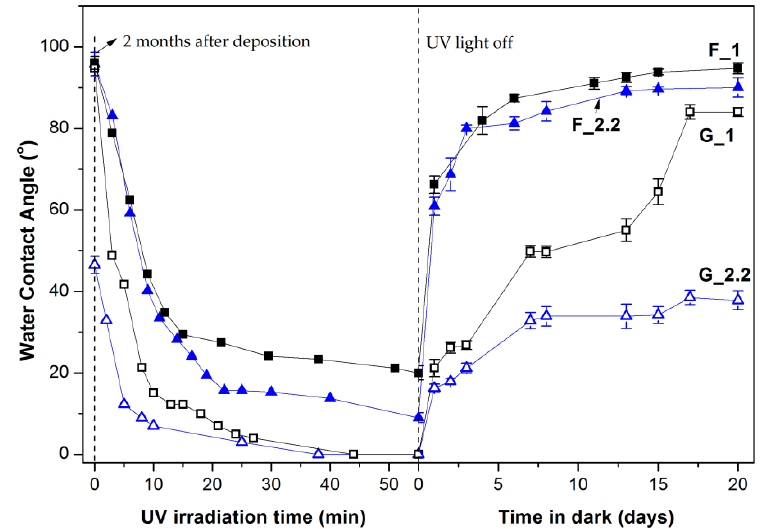
Figure 5. Variation of the water contact angle of the TiO 2 films with UV irradiation (8 mW/cm 2 ) time and with storage time of the samples in dark and ambient conditions.